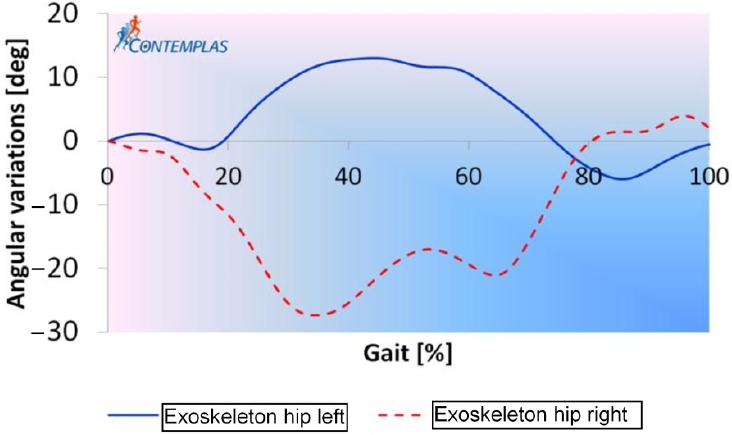
Figure 27. Exoskeleton hip joints angular variation for a complete gait without foot and ground contact.